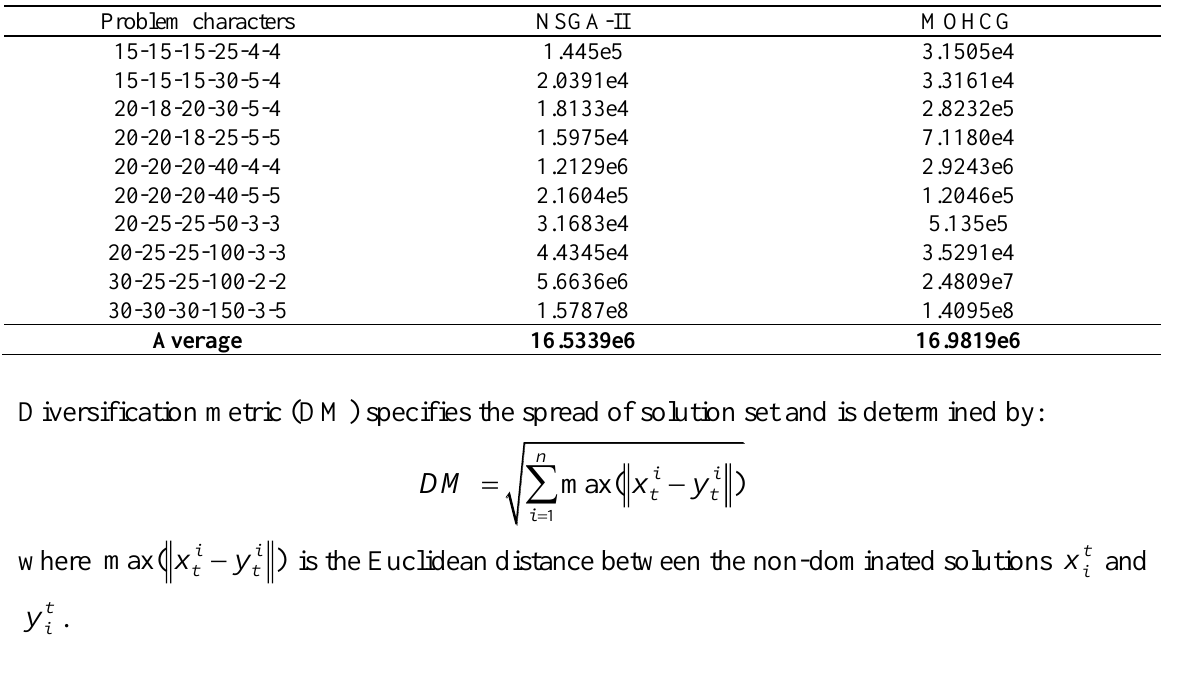
Table 4 . SM measure for medium/large-sized